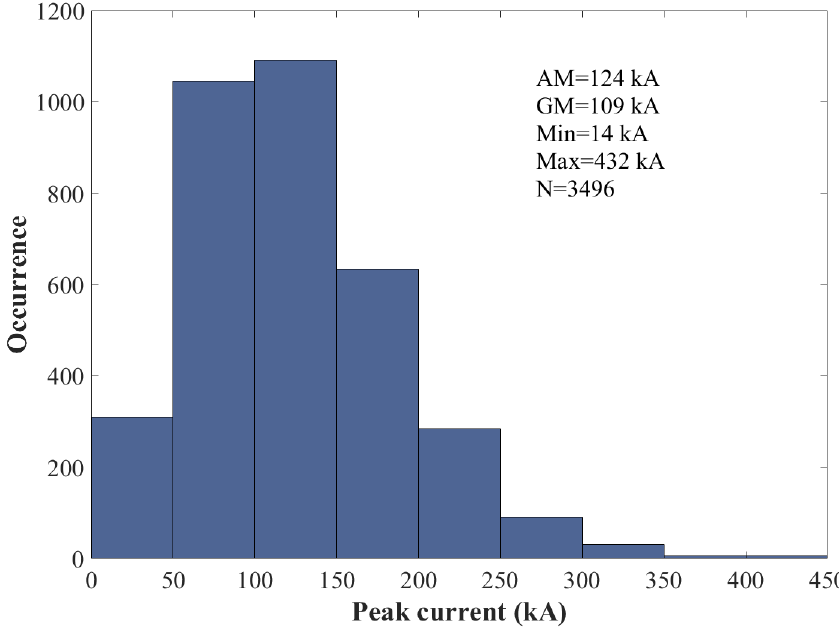
Figure 4. Histogram of NLDN-reported peak currents for the 3496 negative first strokes in flashes with detectable PB pulse trains. The arithmetic mean (AM) and geometric mean (GM) distances to LOG for the 3496 flashes are 229 and 201 km, respectively.